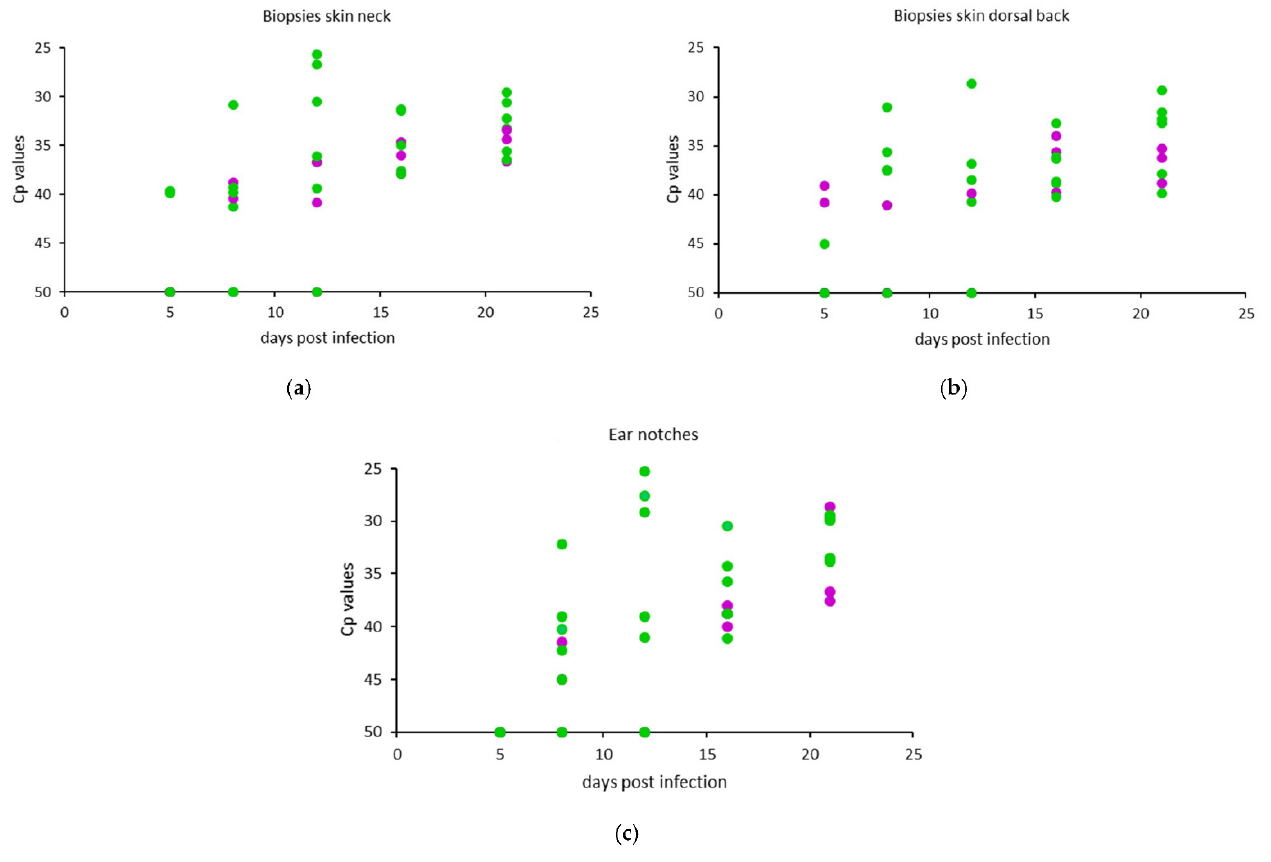
Figure 6. Cp values of ( a ) skin biopsies taken from the neck area, ( b ) skin biopsies taken from the dorsal back and ( c ) ear notches. The Cp values of the clinically infected animals are presented in green, and those of the subclinically infected animals are presented in purple.